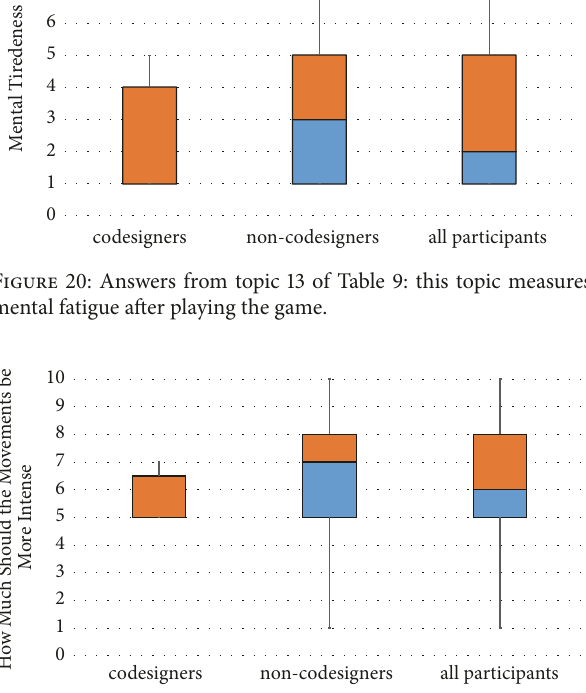
Figure21:Answersfromtopic14ofTable9:thistopicmeasureshow much testers would prefer the movements in the game to be more